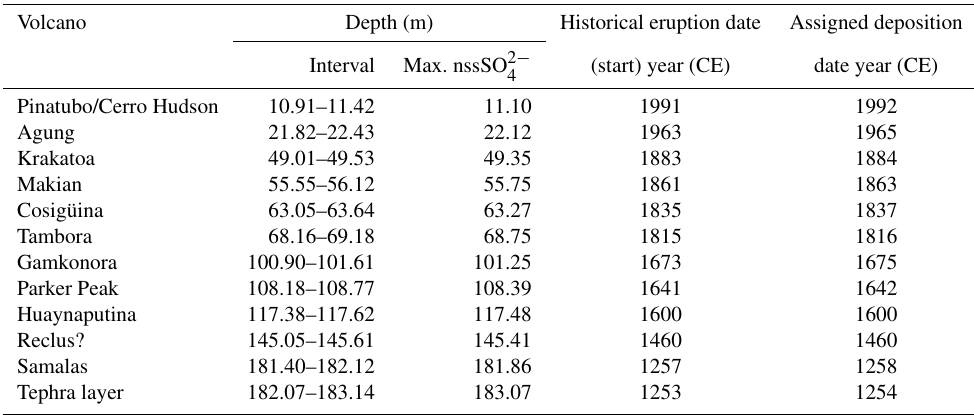
Figure 3. Seasonal variability of Ca 2 + (a) , Cl − (b) , Mg 2 + (c) , Na + (d) , MSA (e) , nssSO 2 ice core. Concentration bins are 3 “months” in width (JFM, AMJ, JAS, OND) and 5ppb in height except for MSA levels (1ppb) and calcium and magnesium (0.25ppb). Dashed blue lines show the average concentration of each ion in the investigated time interval. Table 1. Past known volcanic eruptions used in the dating of the core. Volcano Depth